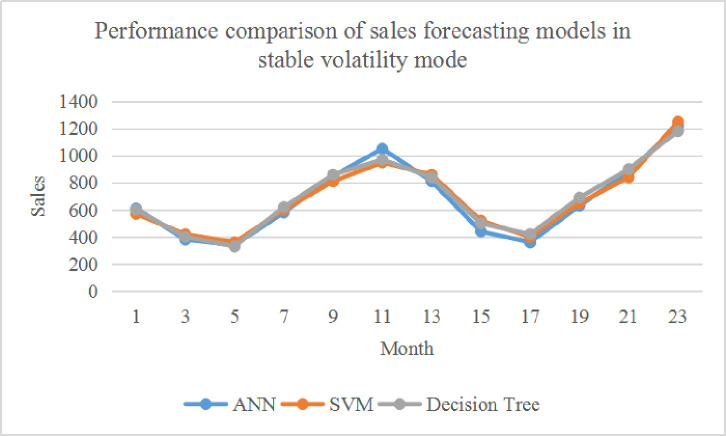
Performance comparison of sales forecasting models in stable volatility mode.